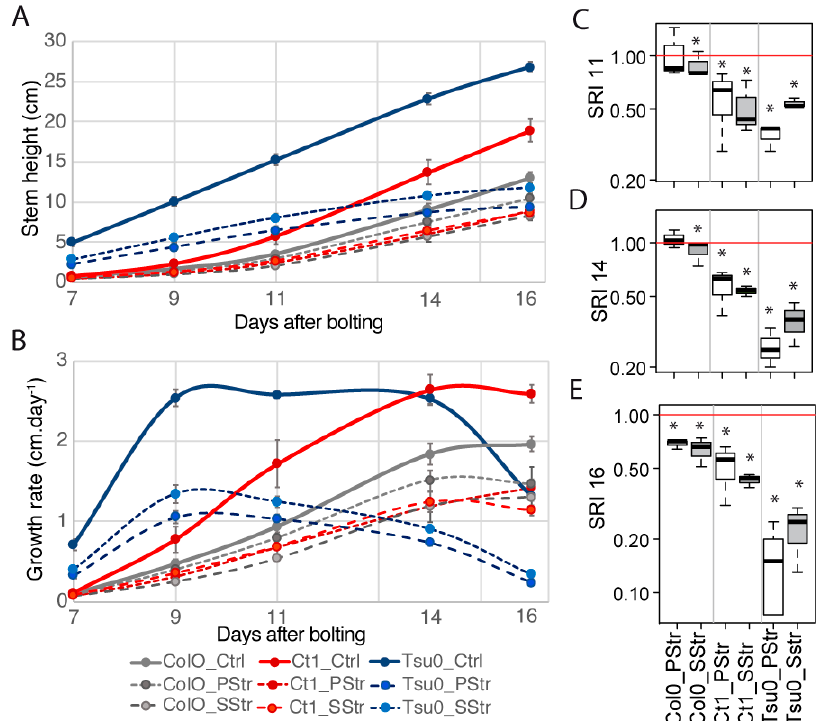
Figure 6. Stem growth in response to high salinity in Arabidopsis . Growth of the stem for the Ctrl, PStr, and SStr plants. The height of the stem was recorded at 7, 9, 11, 14, and 16 DAB. ( A ) The height of the stem and ( B ) the stem daily growth rate. The curves represent the mean ± SE ( n = 9–18) for each time point. ( C – E ) The box and whisker plots represent the distribution of the biological replicates (see Figure 2 for details). ( C – E ) Salt response index (SRI) of the main stem at 11 ( C ), 14 ( D ), and 16 DAB ( E ). Stars denote significant differences of the treatments compared to the control plants (* p < 0.05, n ≥ 9). In white—PStr plants. In grey—SStr plant.